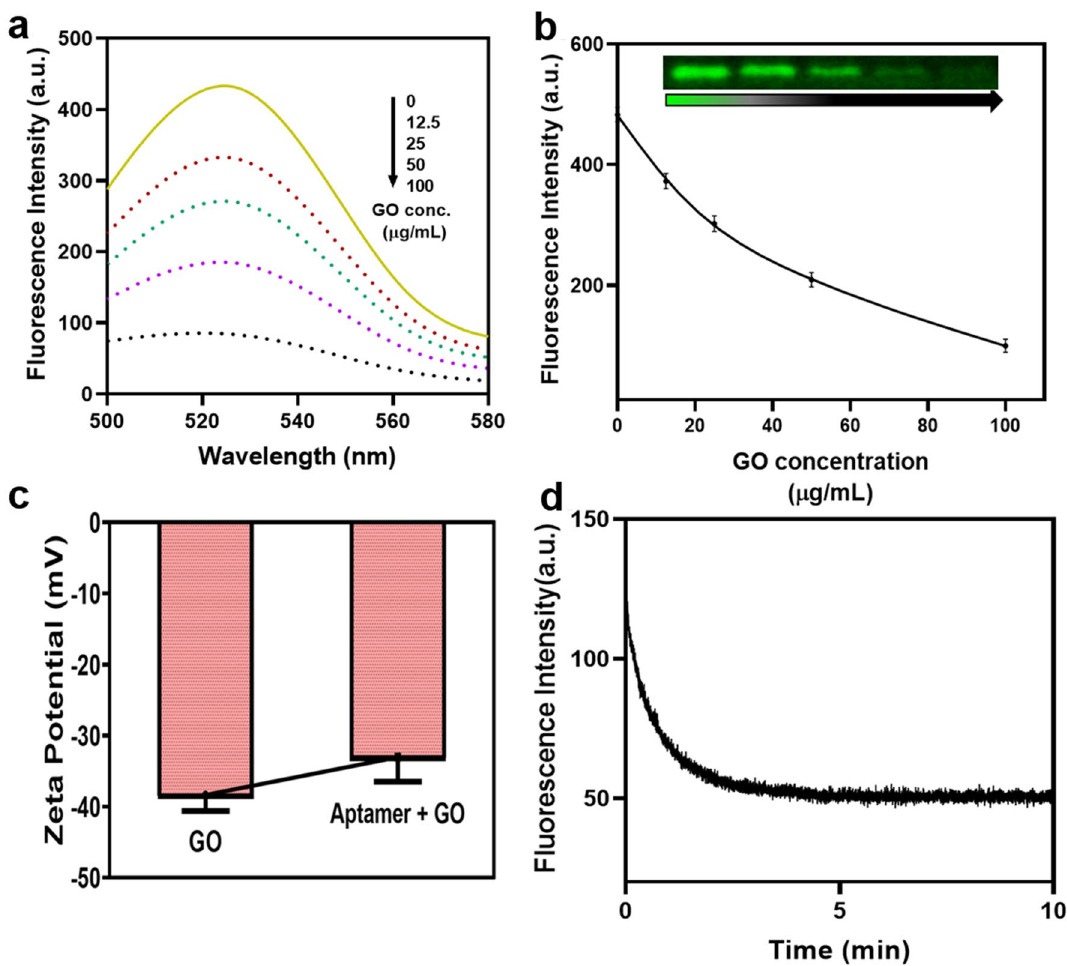
Figure 3. Graphene oxide and aptamer optimization. ( a ) Fluorescent spectra of aptamer with various concentration of GO. (12.5 µg/mL, 25 µg/mL, 50 µg/mL and 100 µg/mL) ( b ) Quantitative and qualitative (agarose gel) results of aptamer fluorescence with increasing concentration of GO. Inset: Peak fluorescence change shows a linear relationship with Graphene oxide concentration. ( c ) Zeta potential of Apt and Apt-GO ( d ) Time kinetics of fluorescence quenching in presence of 50